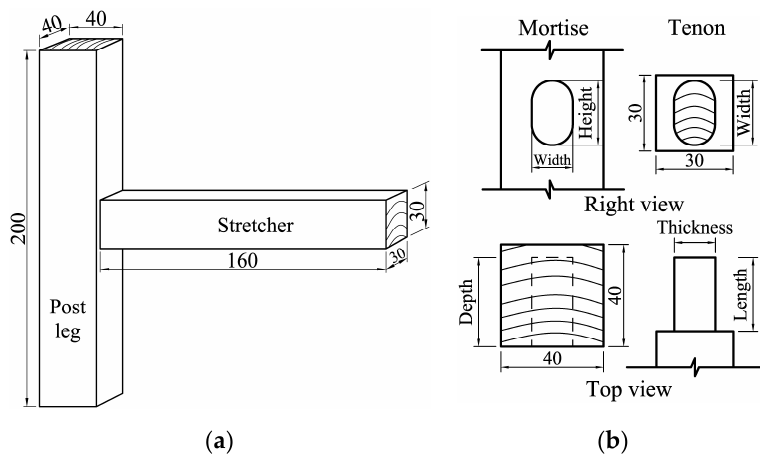
Figure 1. Dimensions of ( a ) T-shaped specimens and ( b ) mortise-and-tenon joint (unit mm).